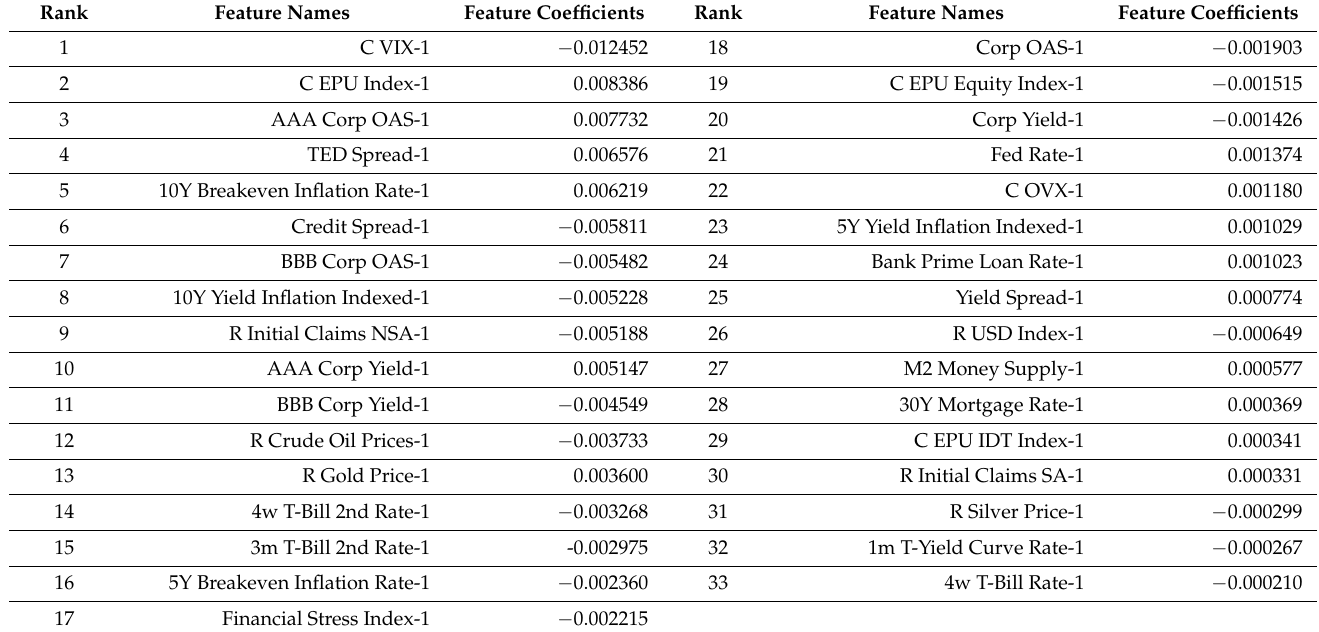
Table A4. Complete list of weekly ranked features and their coefficient from Logistic Regression. Numbers are truncated to four decimal